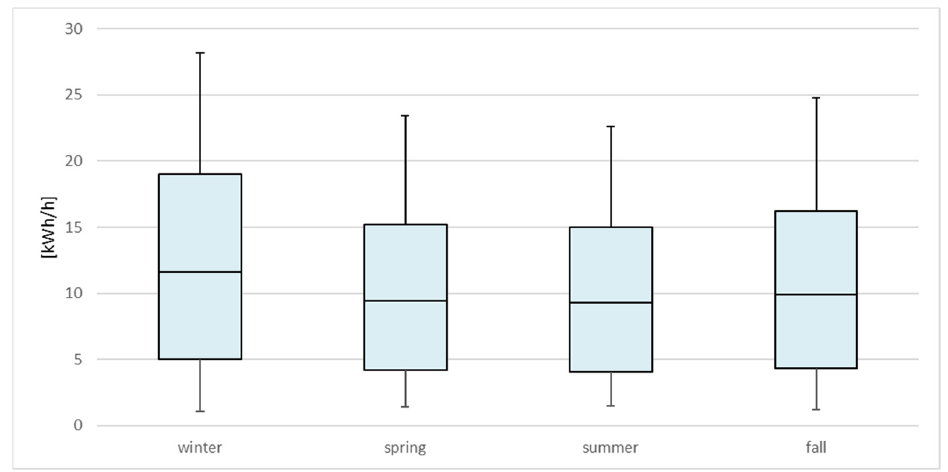
Figure 4. Box and whiskers plots for hourly consumption in each season in 2020 (urban).